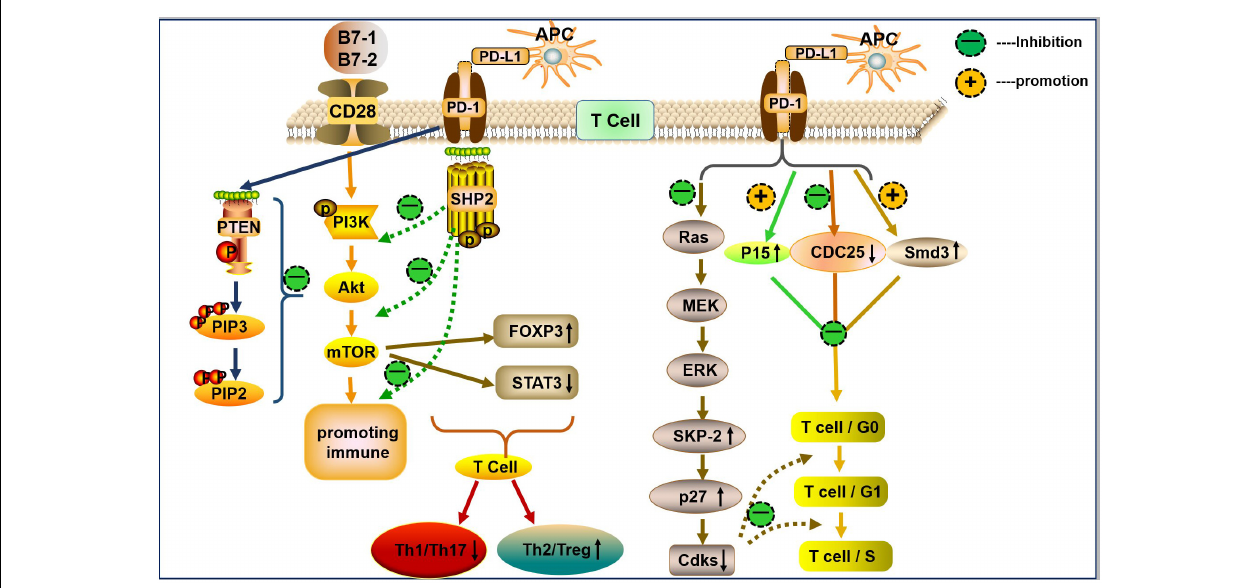
FIGURE 1 | The PD-1/PD-L1 axis in T cells differentiation and proliferation. PD-L1 (mainly expressed on APCs) binds to PD-1 on the surface of T cells and generates a co-inhibitory signal. The PD-1/PD-L1 interaction recruits SHP2 to block CD28-mediated activation of PI3K and AKT (i.e., reduce the levels of p-P13K and p-AKT). PD-L1 decreases the activity of mTOR by inhibiting p-AKT, and the mTOR pathway upregulates the expression of Foxp3 ( ↑ ) and downregulates the expression of p-STAT3 ( ↓ ), thereby inducing Treg/Th2 differentiation and inhibits Th1/Th17 cell differentiation. PD-L1 can promote the expression of PTEN. PTEN dephosphorylates the inositol PIP 3 on cell membranes to generate PIP 2 and then antagonizes PI3K, which mediates cell growth, metabolism, proliferation, and survival signals. The PD-1/PD-L1 interaction inhibits Ras, which inhibits the activation of downstream MAPK/ERK signaling, leading to a reduction in ubiquitin ligase SCF Skp 2 -driven degradation of p27 kip 1 . This process results in the accumulation of p27 kip 1 , inhibition of Cdks, and further inhibition of T cell proliferation. Furthermore, PD-1 inhibits T cell proliferation by upregulating p27, p15, and Smad3, but inhibiting